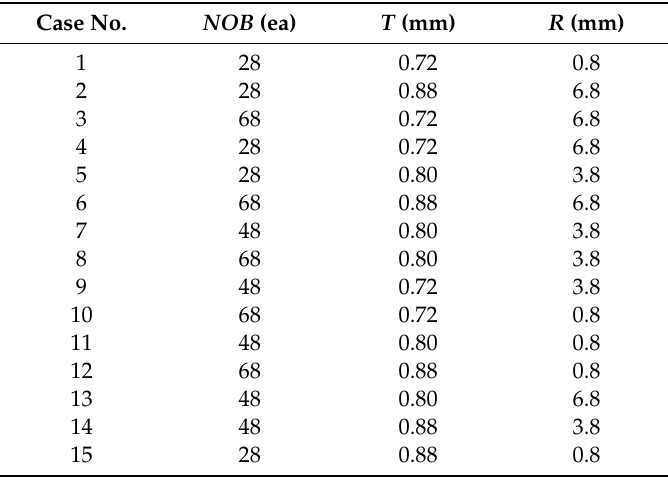
Table 3. Numerical analysis sets by